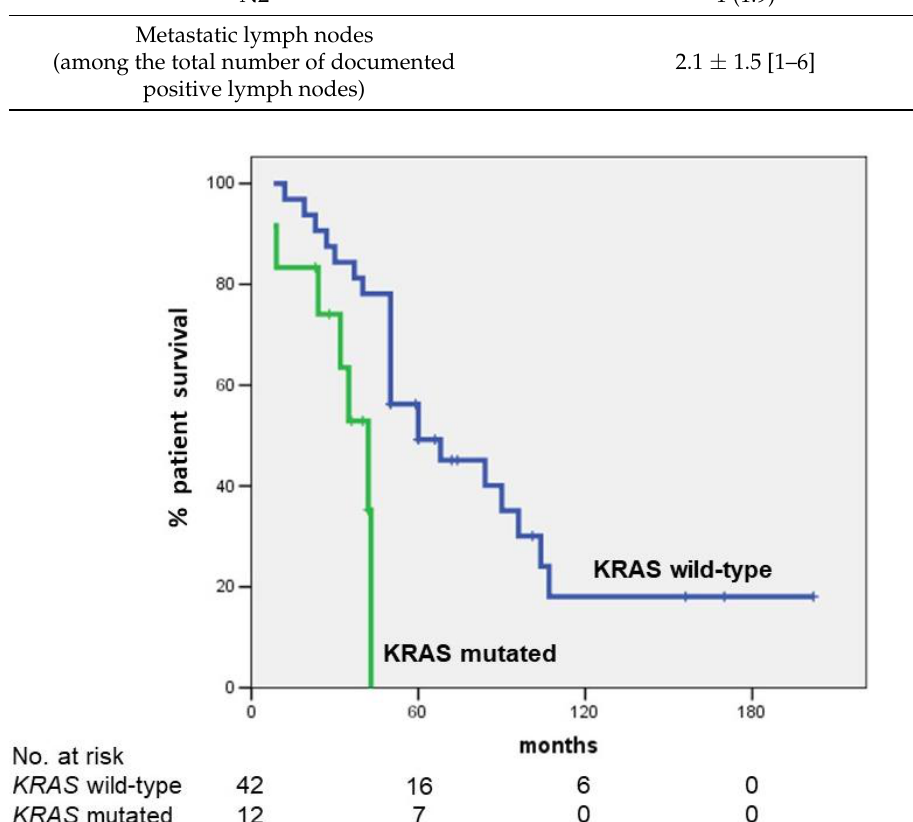
Figure 1. Five-year OS according to KRAS mutational status. Five-year OS in patients with KRAS mutation was significantly lower than that observed in patients with KRAS wild type (0 vs. 49.2%, respectively; p = 0.003). The median survival was 42 months in patients with KRAS mutation and 60 months in patients with KRAS wild type.